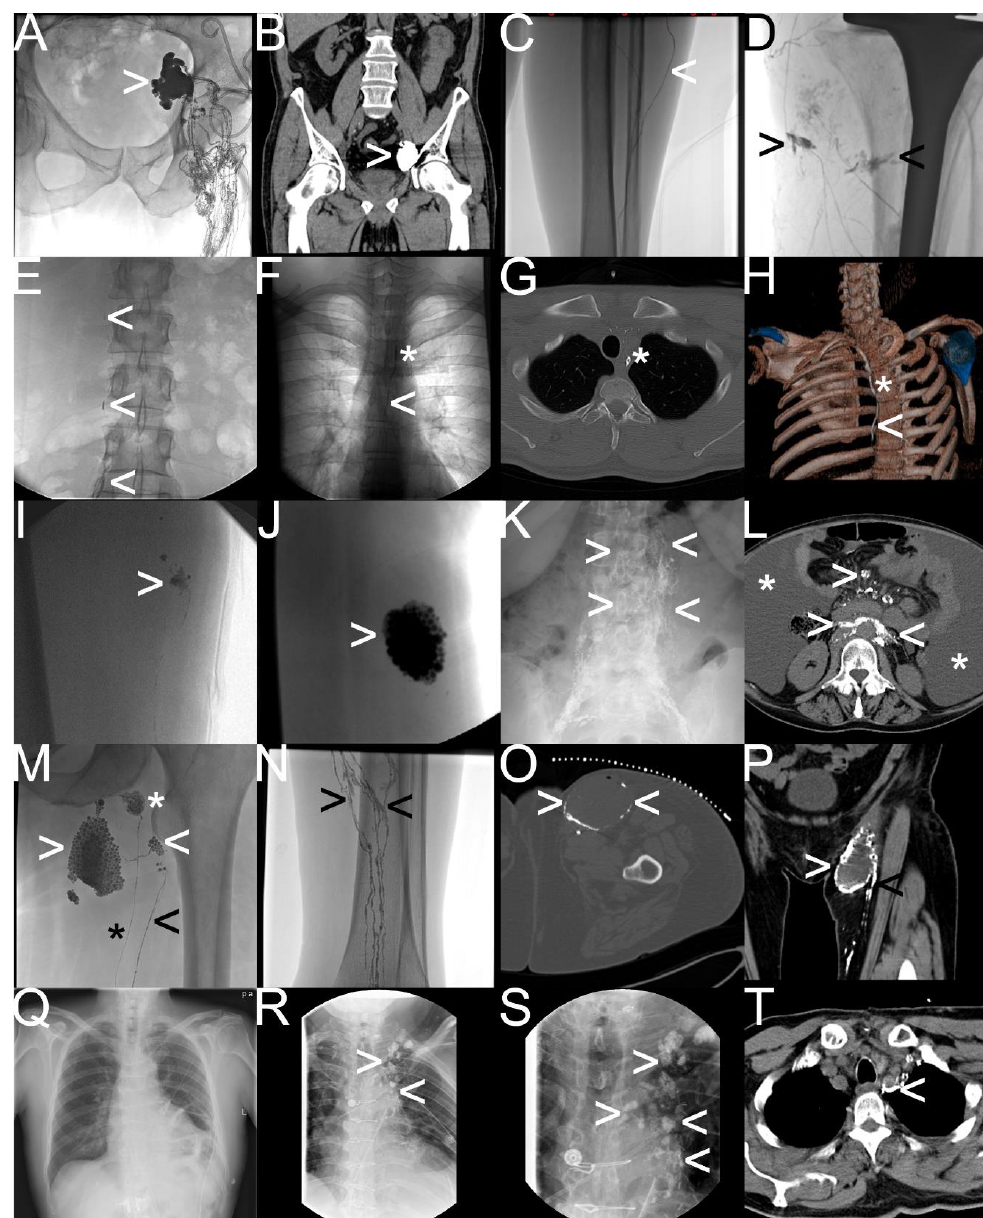
Figure 5. Different types of iatrogenic lymphatic fistulas detected by “conventional lymphan- giography“. Note: ( A , B ) after robot-assisted prostatectomy—iliac lymphocele (white arrow- head); ( C , D ) after total-knee arthroplasty—lymphatic feeder (white arrowhead) and percuta- neous lymphatic fistulas (black arrowhead) leading to wound-healing disorder; ( E – H ) after radical thyroidectomy—mediastinal lymphatic fistula from the thoracic duct (white arrowhead) draining into the intraoperatively inserted drainage tube (white asterisk); ( I , J ) after soft tissue resection—typical lymphocele with blowout of oil-containing contrast material; ( K , L ) after chemother- apy for non-Hodgkin’s lymphoma—chylaskos (white asterisk), and chylothorax with pathological accumulation of the oil-containing contrast material in retroperitoneal and mesenteric lymph nodes; ( M – P ) postoperative lymphocele (white arrowhead) and lymphatic feeder (black arrowhead) with impaired lymphatic run-off in the calf (black arrowhead) in contrast to a healthy lymph node (white as- terisk) and a healthy lymph duct (black asterisk); ( Q – T ) after cardiac surgery—refractory chylothorax and chylopericardium with multifocal pathologic extravasation and accumulation of oil-containing contrast material in the mediastinum (white